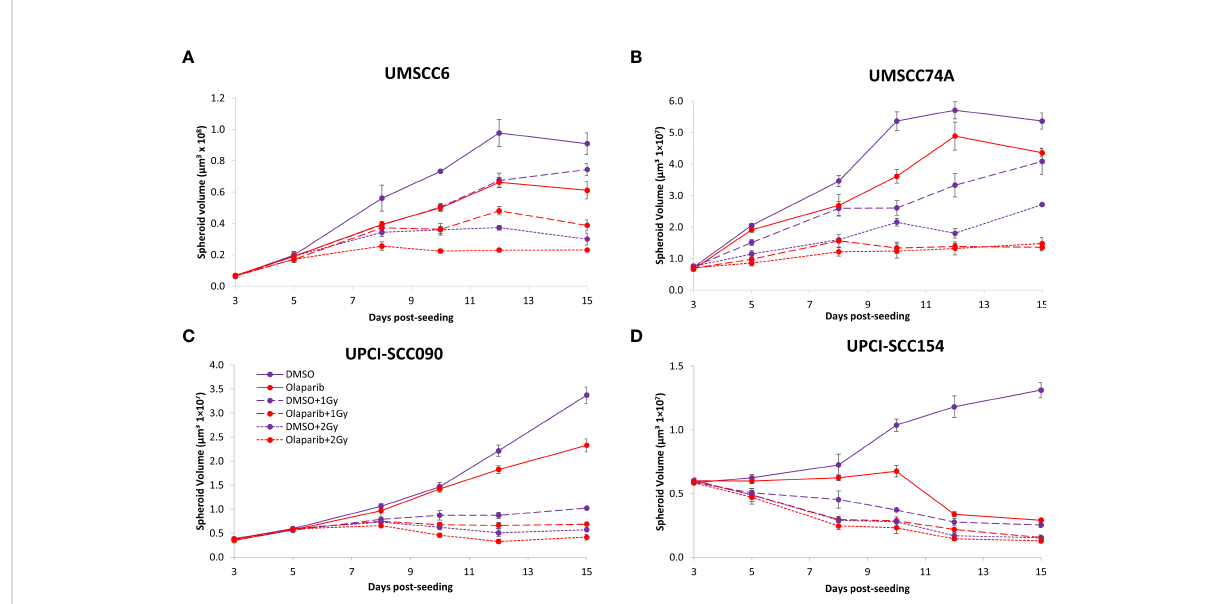
FIGURE 2 Impact of olaparib on the radiosensitivity and growth of HPV-negative and HPV-positive OPSCC spheroids. Spheroids were allowed to develop for 24 h in ultra-low-attachment plates, treated with DMSO or olaparib (0.1 µM) for a further 24 h, and then unirradiated or irradiated (1 or 2 Gy) on day 3 with a single dose of x-rays. Growth of (A, B) HPV-negative OPSCC spheroids (UMSCC6 and UMSCC74A) and (C, D) HPV-positive OPSCC spheroids (UPCI-SCC090 and UPCI-SCC154) was measured by microscopy up to 15 days post-seeding and analysed from three biologically independent